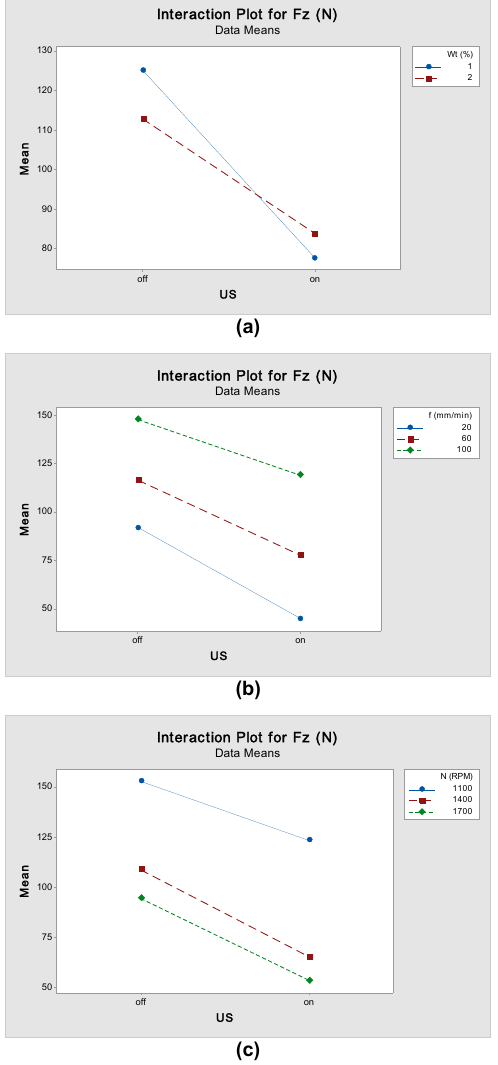
Figure 6. Interactive effect of ultrasonic (US) vibration and: (a) SiC content, (b) feed rate and (c) spindle speed; on thrust force.